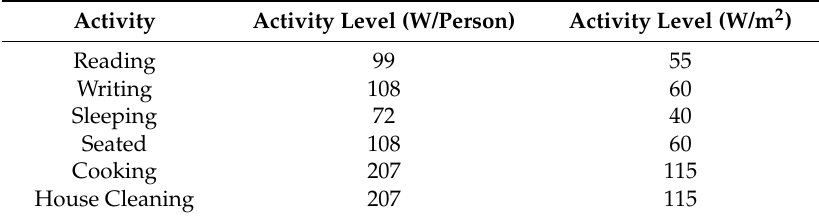
Table 7. Building occupant activity levels worked out using 1.8 m 2 as the Du Bois area for the average person.